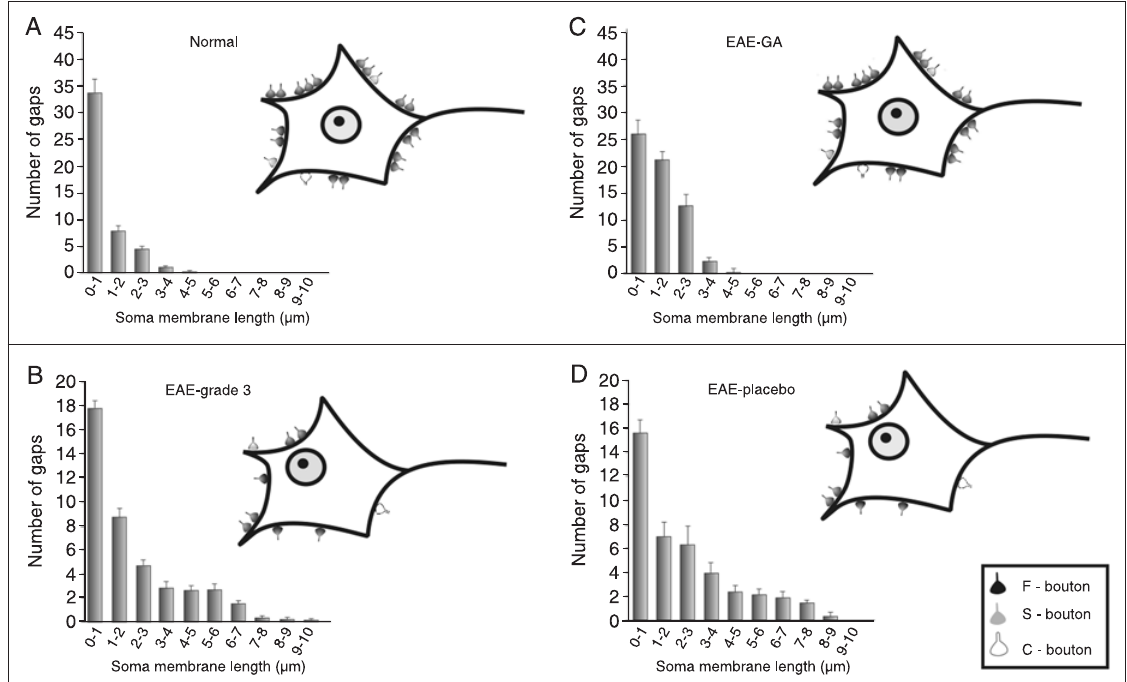
Figure 5. Transmission electron microscope micrographs obtained at the level of the spinal cord ventral horn (L4-L5) showing that the distribution of the gap length between clusters of terminals apposing the cell soma membrane was close to normality after GA treatment. Panel A, Normal distribution of intervals between nerve terminals showing that the boutons were organized in clusters of inputs. Panel B, The distribution of terminals during the exacerbation of the disease (grade 3 = hind leg paralysis). Panel C, Treatment with GA keeps the clusters of terminals stable regardless of the increased surrounding glial reaction. Panel D, EAE-placebo, which was similar to the positive control (grade 3 of the disease). EAE = experimental autoimmune encephalomyelitis; GA = glatiramer acetate; F = flattened vesicles, inhibitory inputs; S = spherical vesicles, excitatory inputs; C = cholinergic